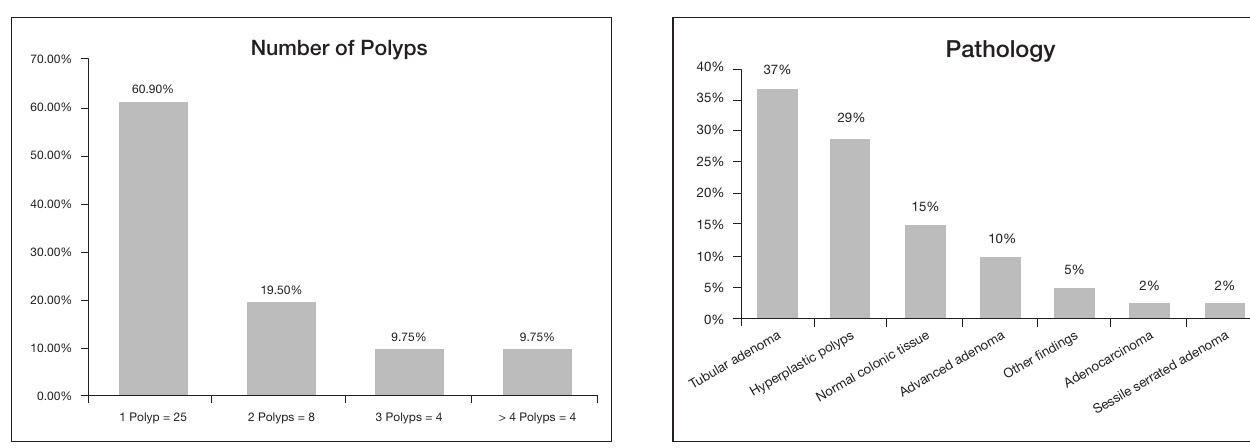
Figure 2) Percentage of patients with ≥ 1 polyp(s) Figure 3) Percentage of different pathological